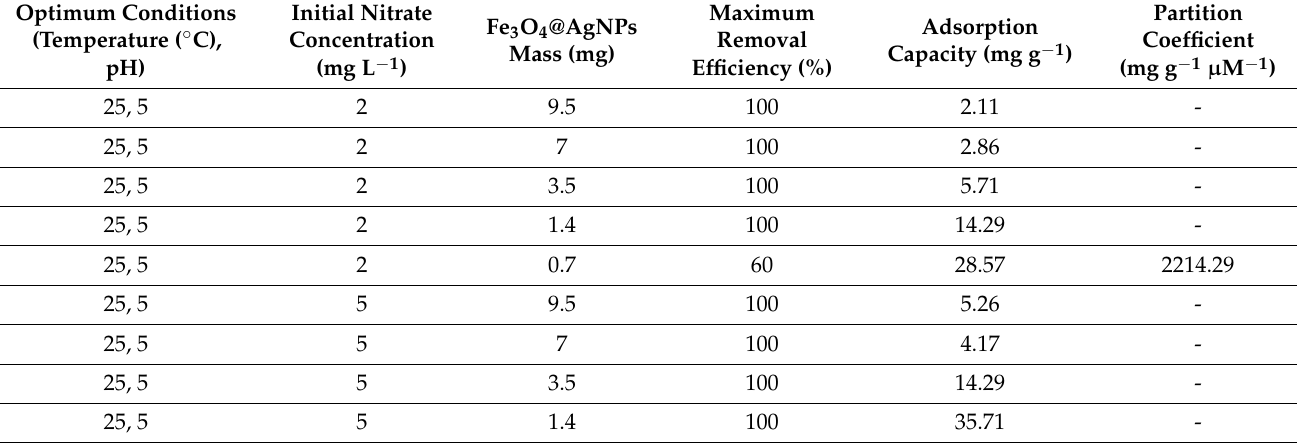
Table 1. Performance metrics of Fe 3 O 4 @AgNPs employed for adsorption of different concentrations of nitrate species in